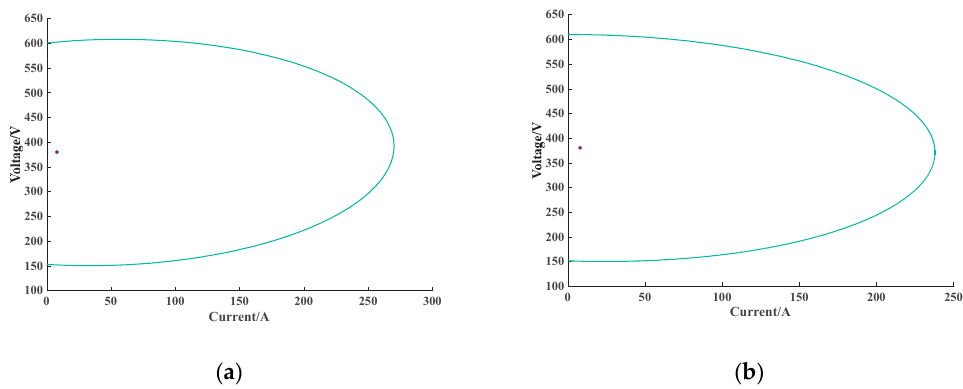
Figure 5. The regions of asymptotic stability (RAS): ( a ) The RAS in the case of battery charging ( b ) The RAS in the case of battery